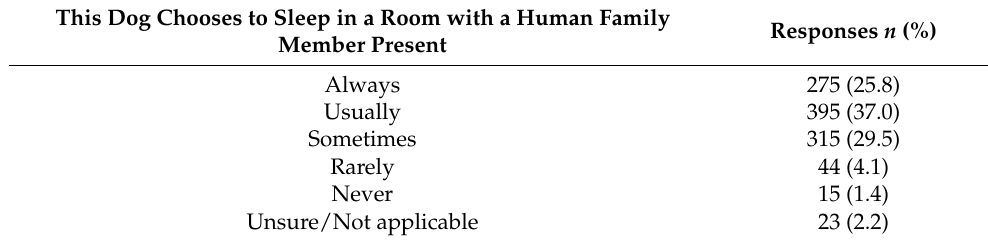
Table 2. Choices made by dogs regarding sleeping with or without human company.